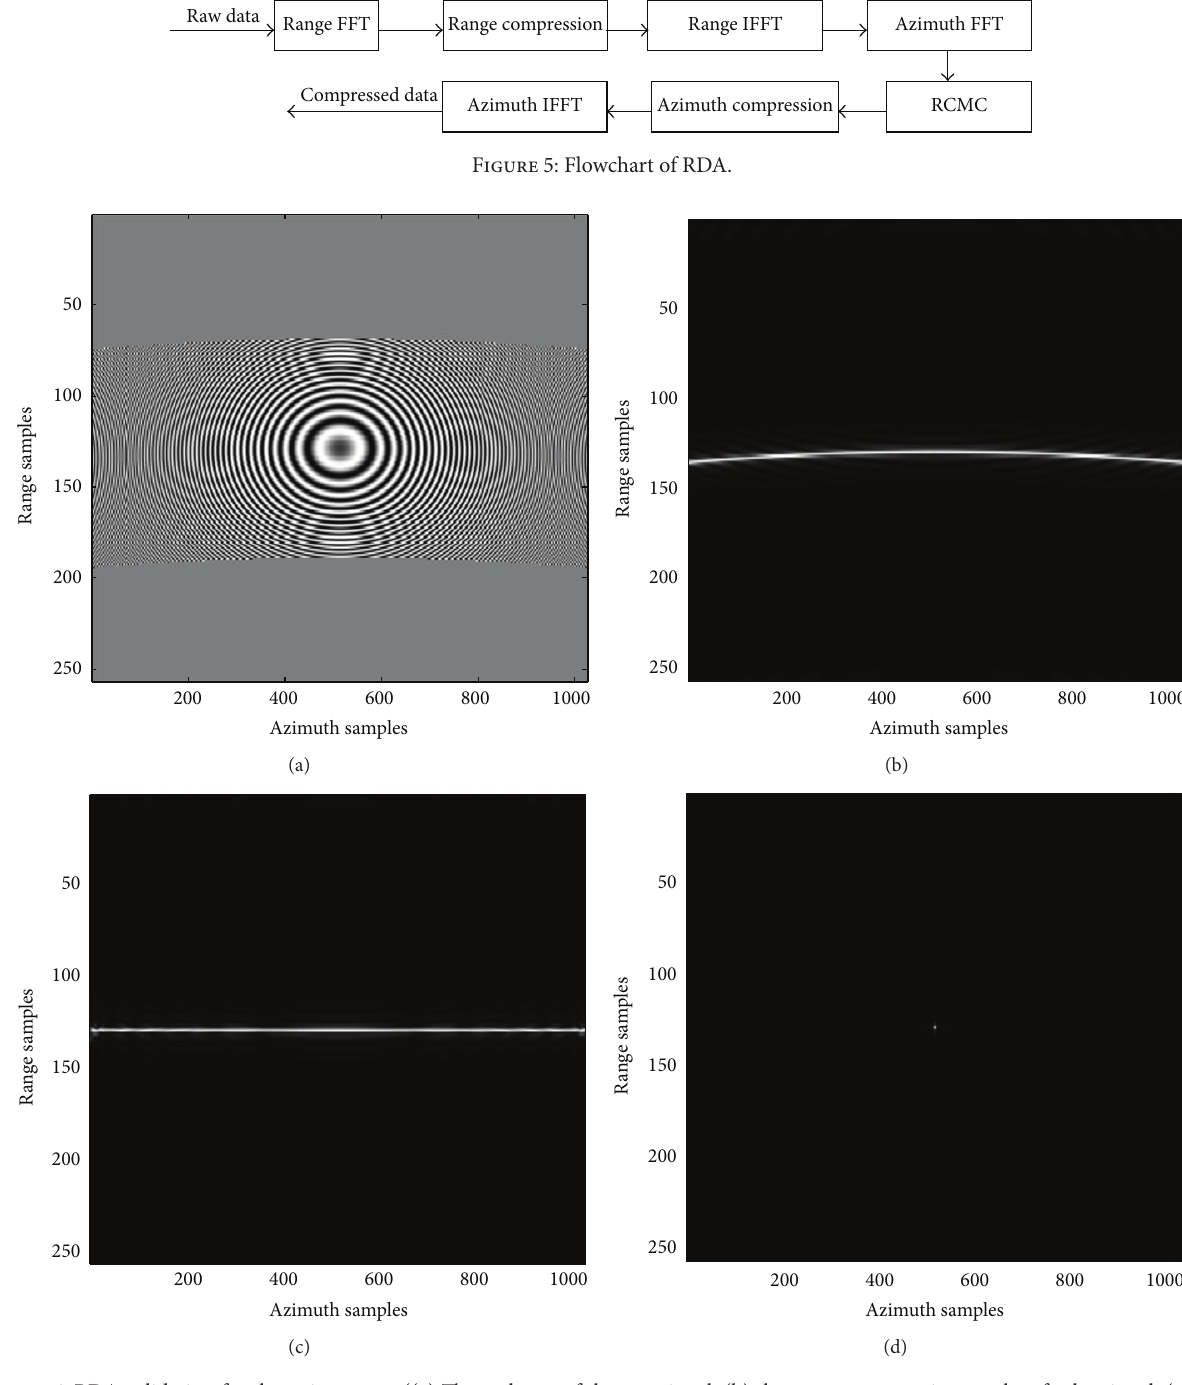
Figure 6: RDA validation for the point target. ((a) The real part of the raw signal; (b) the range compression results of echo signal; (c) the range-Doppler image; (d) the SAR